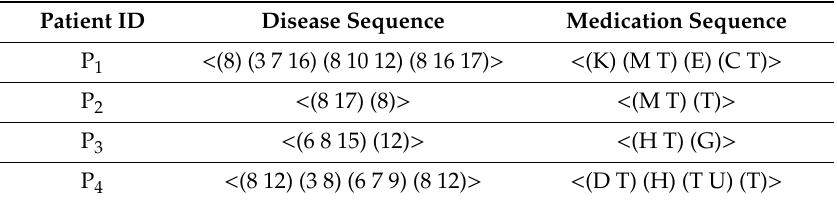
Table 5. Examples of patients’ outpatient sequences.